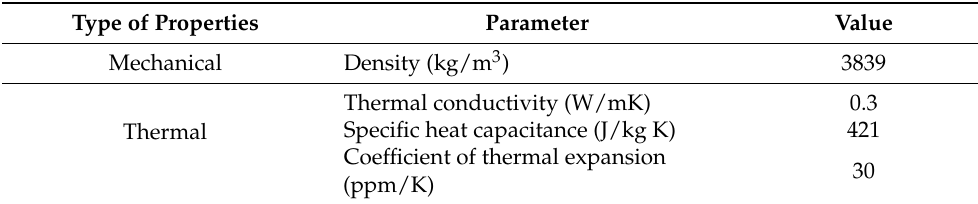
Table 1. Mechanical and thermal properties of the FPCB.